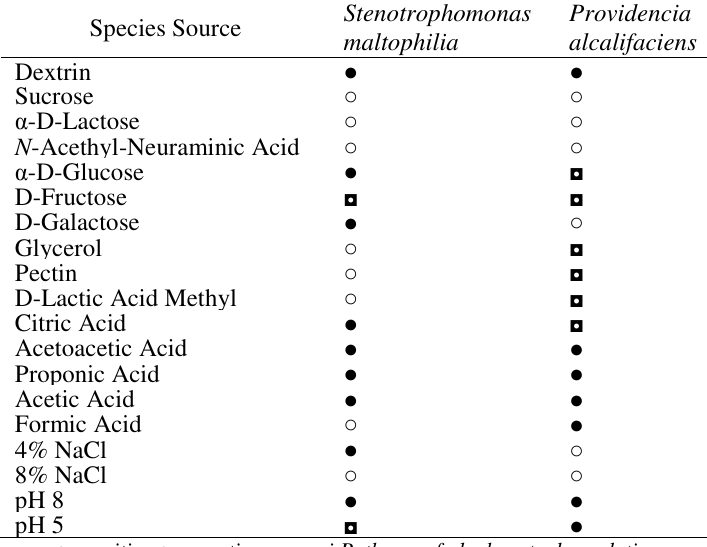
Table 2 . Characteristics of the two glyphosate-utilizing isolates Species Source